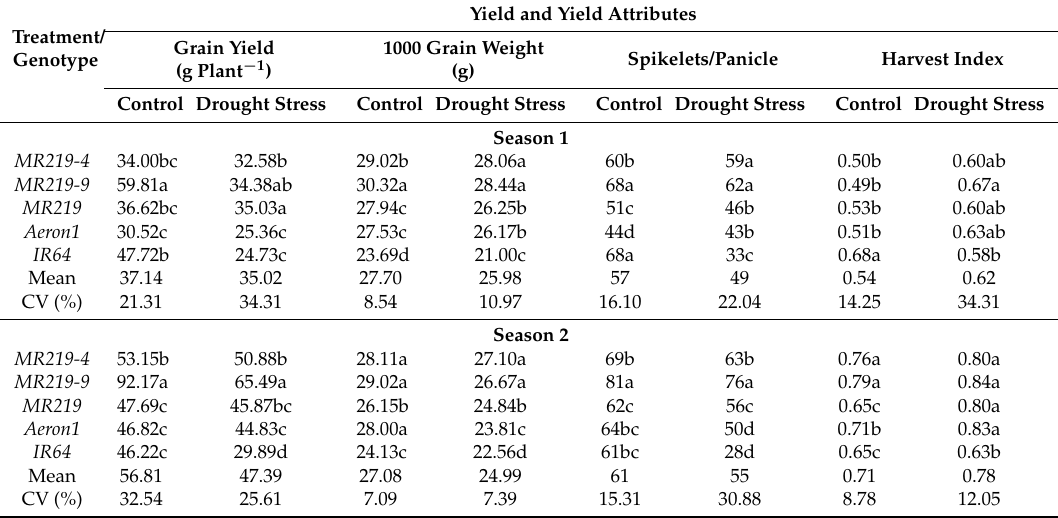
Table 7. Grain yield and 1000 grain weight in rice genotypes as affected by drought stress treatment at different seasons. Treatment/